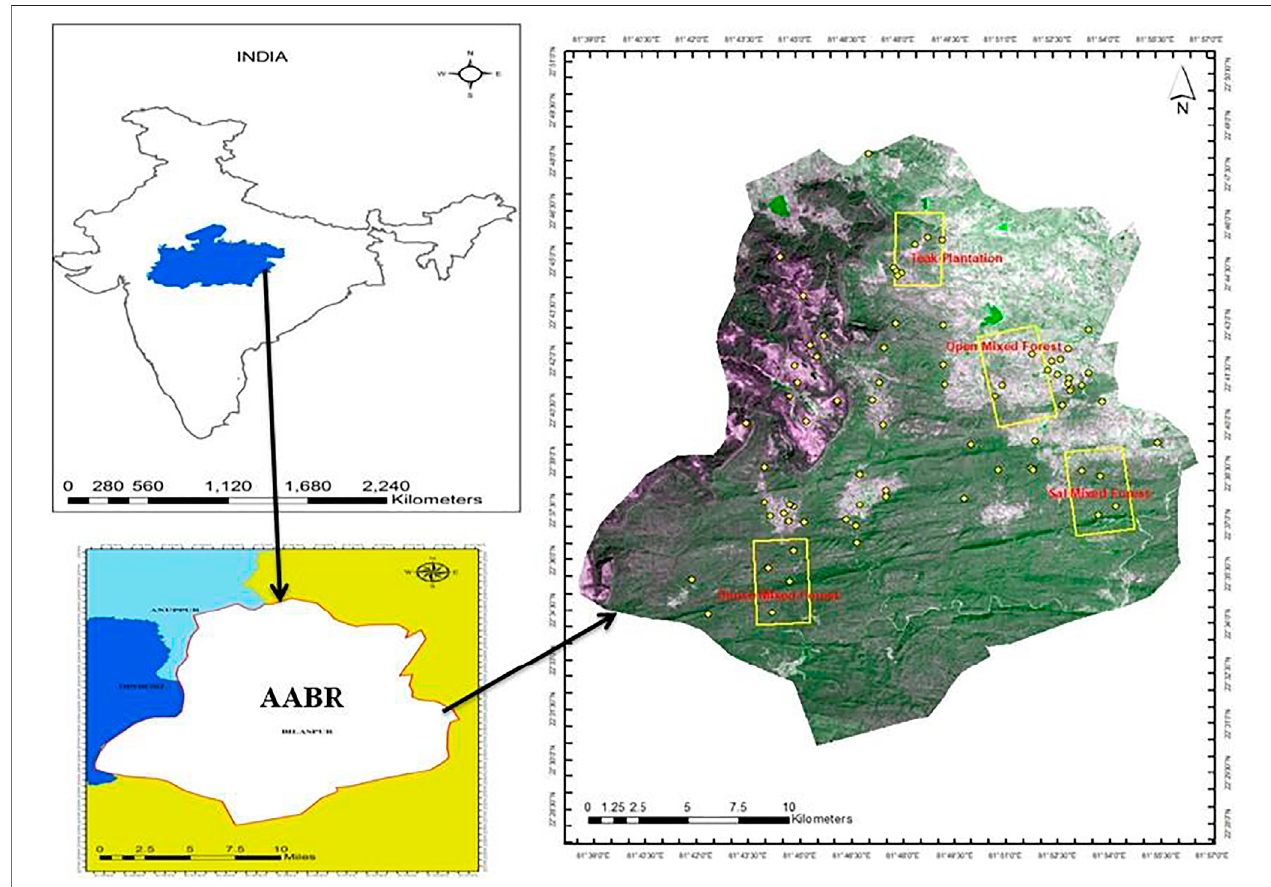
FIGURE 1 | Layout map along with identi fi ed sample plots, in yellow boxes at different locations in dry tropical forests of AABR.